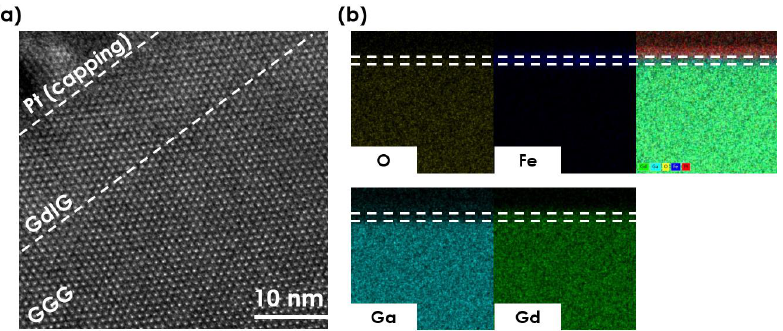
Figure 3. ( a ) TEM and ( b ) EDX images of 750 °C annealed GGG|GdIG sample. As GGG and GdIG have similar structure and lattice parameters, a smooth interface appears, indicating an epitaxial growth of GdIG. ( b ) The presence of Gd and Fe and the absence of Ga at the marked region represent the formation of the GdIG layer.